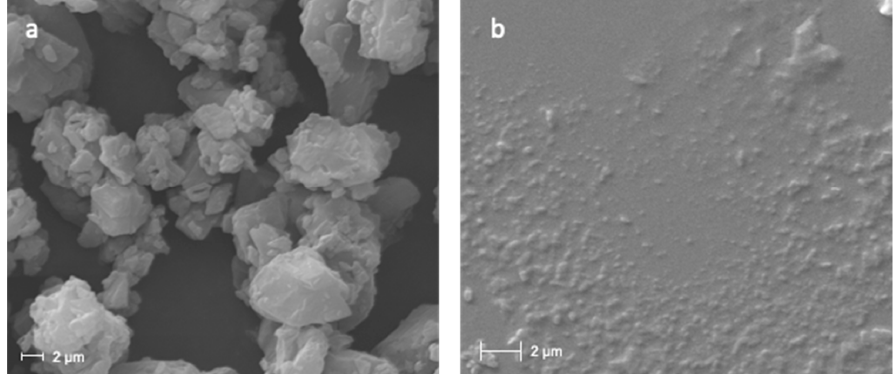
Figure 1. ESEM micrographs of CUR bulk powder ( a ) and CUR Nanocrystals ( b ).